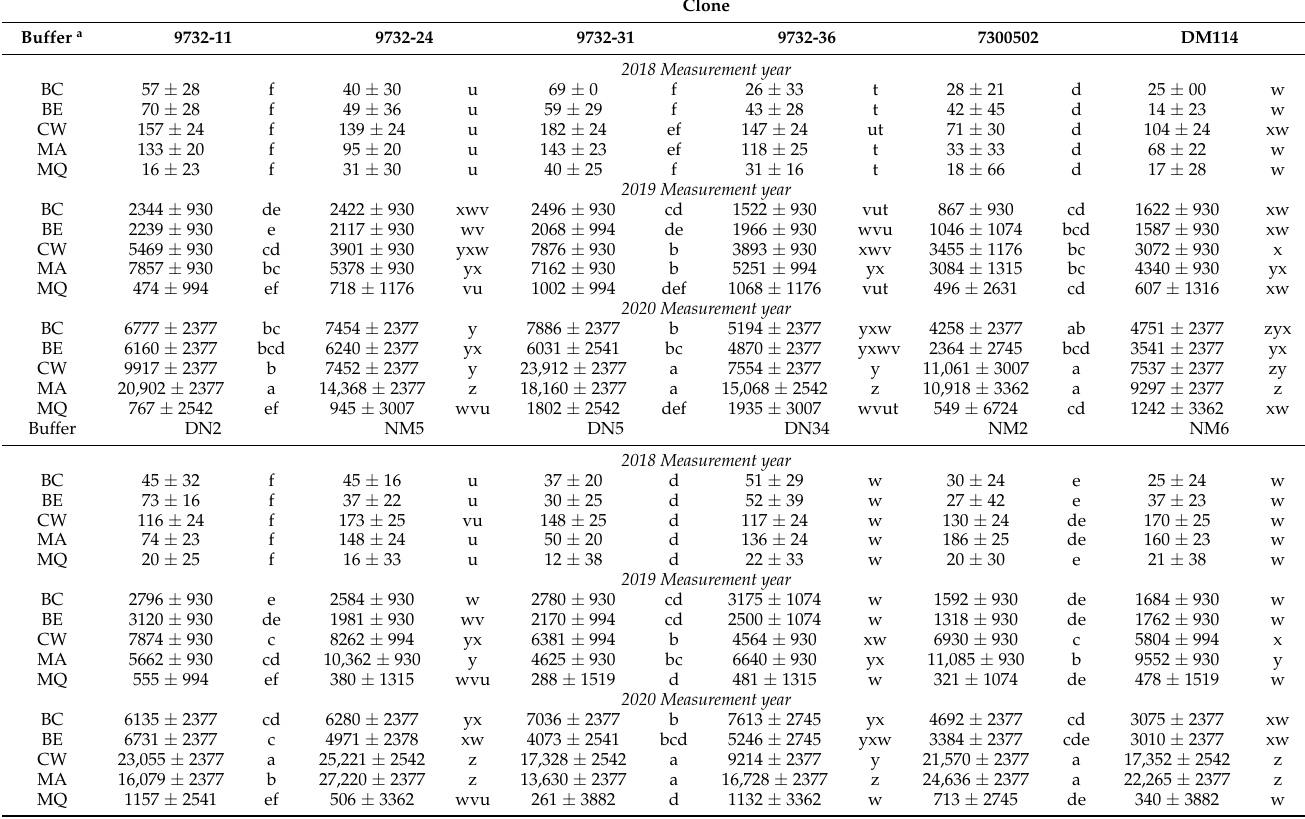
Table 6. Volume (cm 3 ) ( ± one standard error) of twelve poplar clones tested in five phytoremediation buffer systems (i.e., phyto buffers) established in 2018 (i.e., the 2018 buffer group) in the Lake Superior watershed of the Upper Peninsula of Michigan, USA and the Lake Michigan watershed of eastern Wisconsin, USA. Trees were measured following the 2018, 2019, and 2020 growing seasons. Volume values with different letters within a clone column across measurement years are different at P <